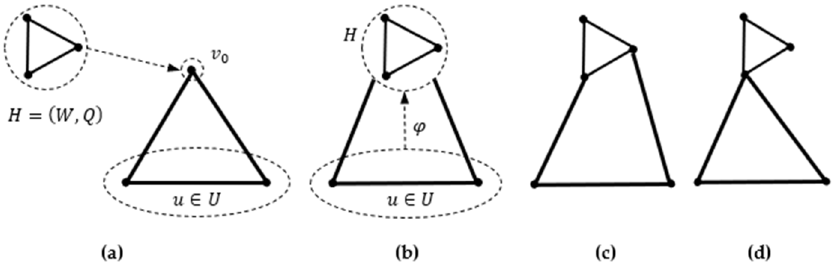
Figure 1. Operation of the replacement of vertex v 0 by seed H : ( a ) selection of a vertex for replacement and a replacement seed; ( b ) replacing a vertex and determining the environment of incident edges; ( c ) old edges are not adjacent; ( d ) the adjacency of the old edges is preserved.